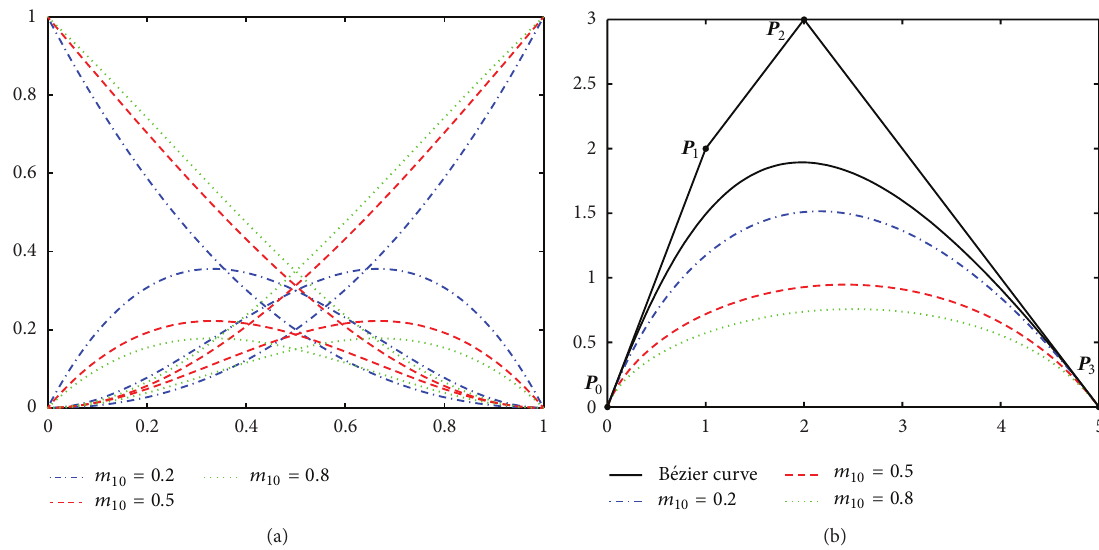
Figure 3: Quasi-Bernstein basis functions and Quasi-B´ezier curves when 𝑛 1 = 3 and 𝑛 2 = 3 .